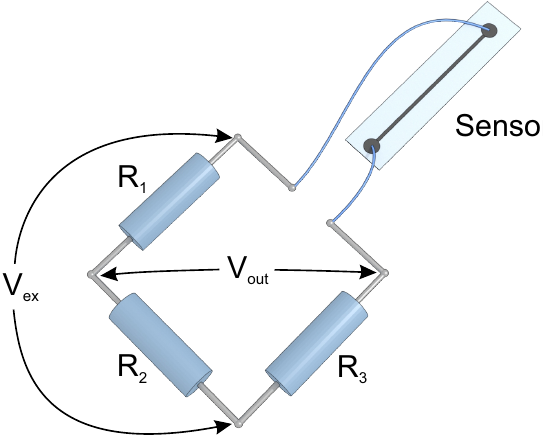
Figure 3. Experimental setup used to calibrate the investigated strain sensors.